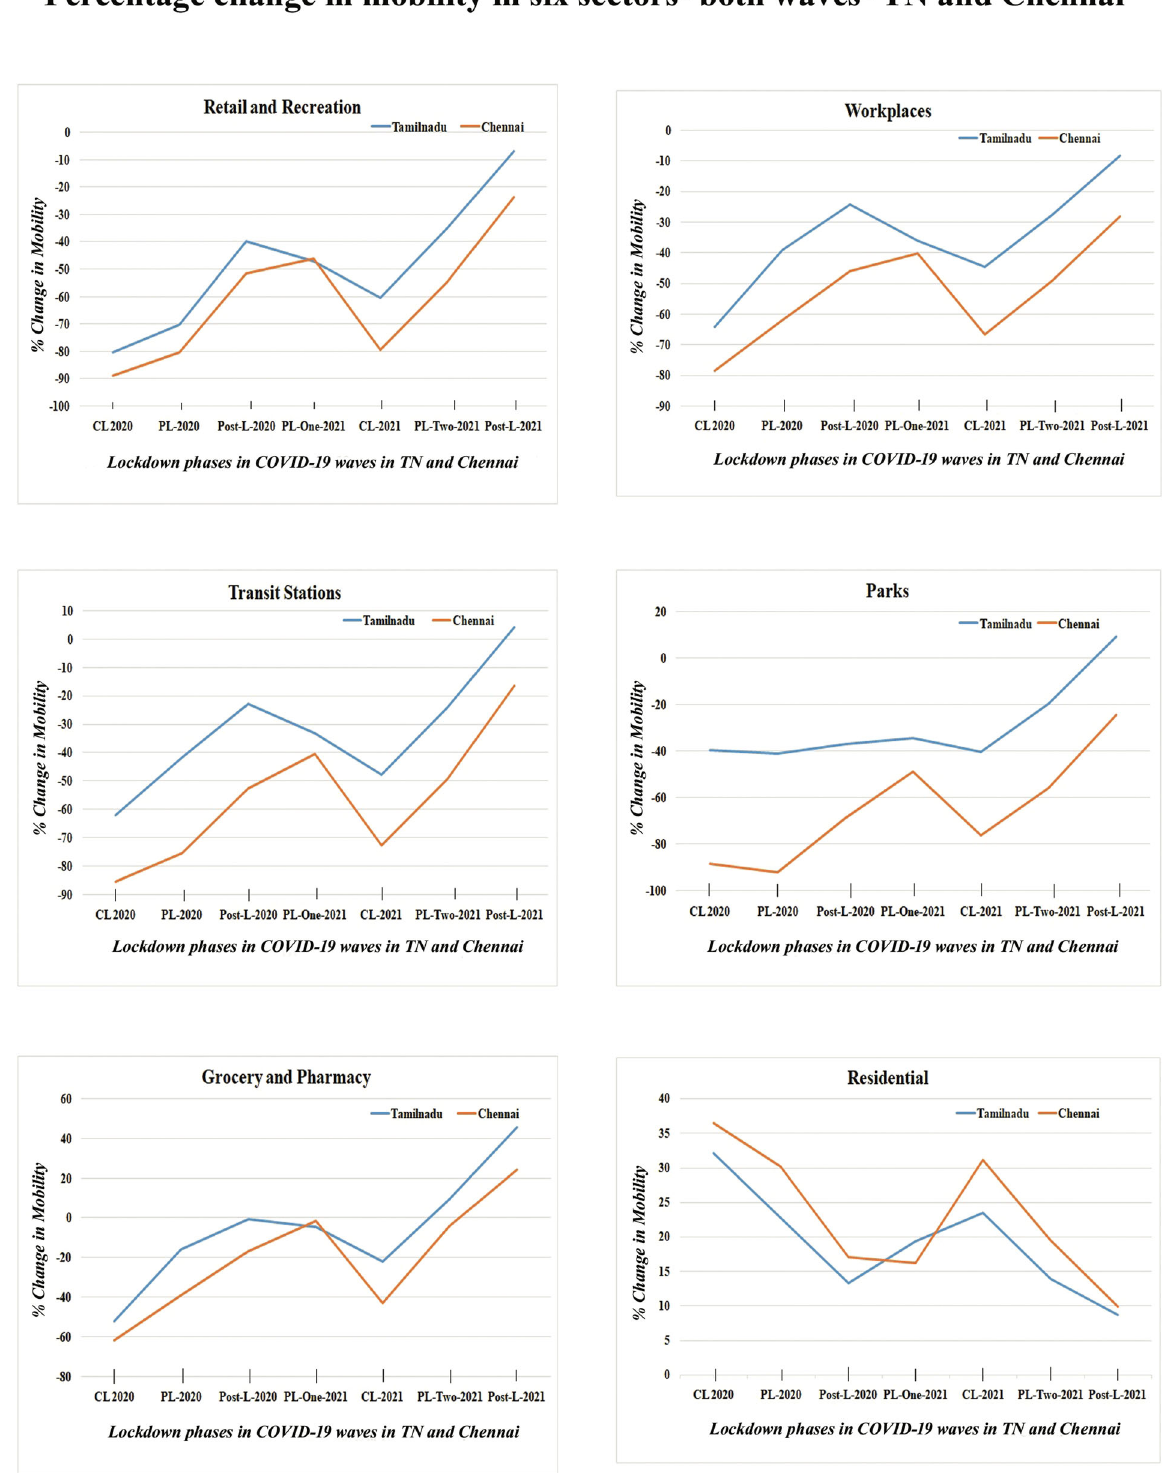
Fig. 5 Mean percentage change in mobility from the baseline in six community spaces during various phases of lockdown in both waves in 2020 and 2021 in Tamil Nadu and Chennai City. The X -axis depicts the various stages of lockdown in discrete intervals (CL complete lockdown, PL partial lockdown, Post-L post-lockdown), and Y -axis shows the mean percentage change in mobility from baseline in different community